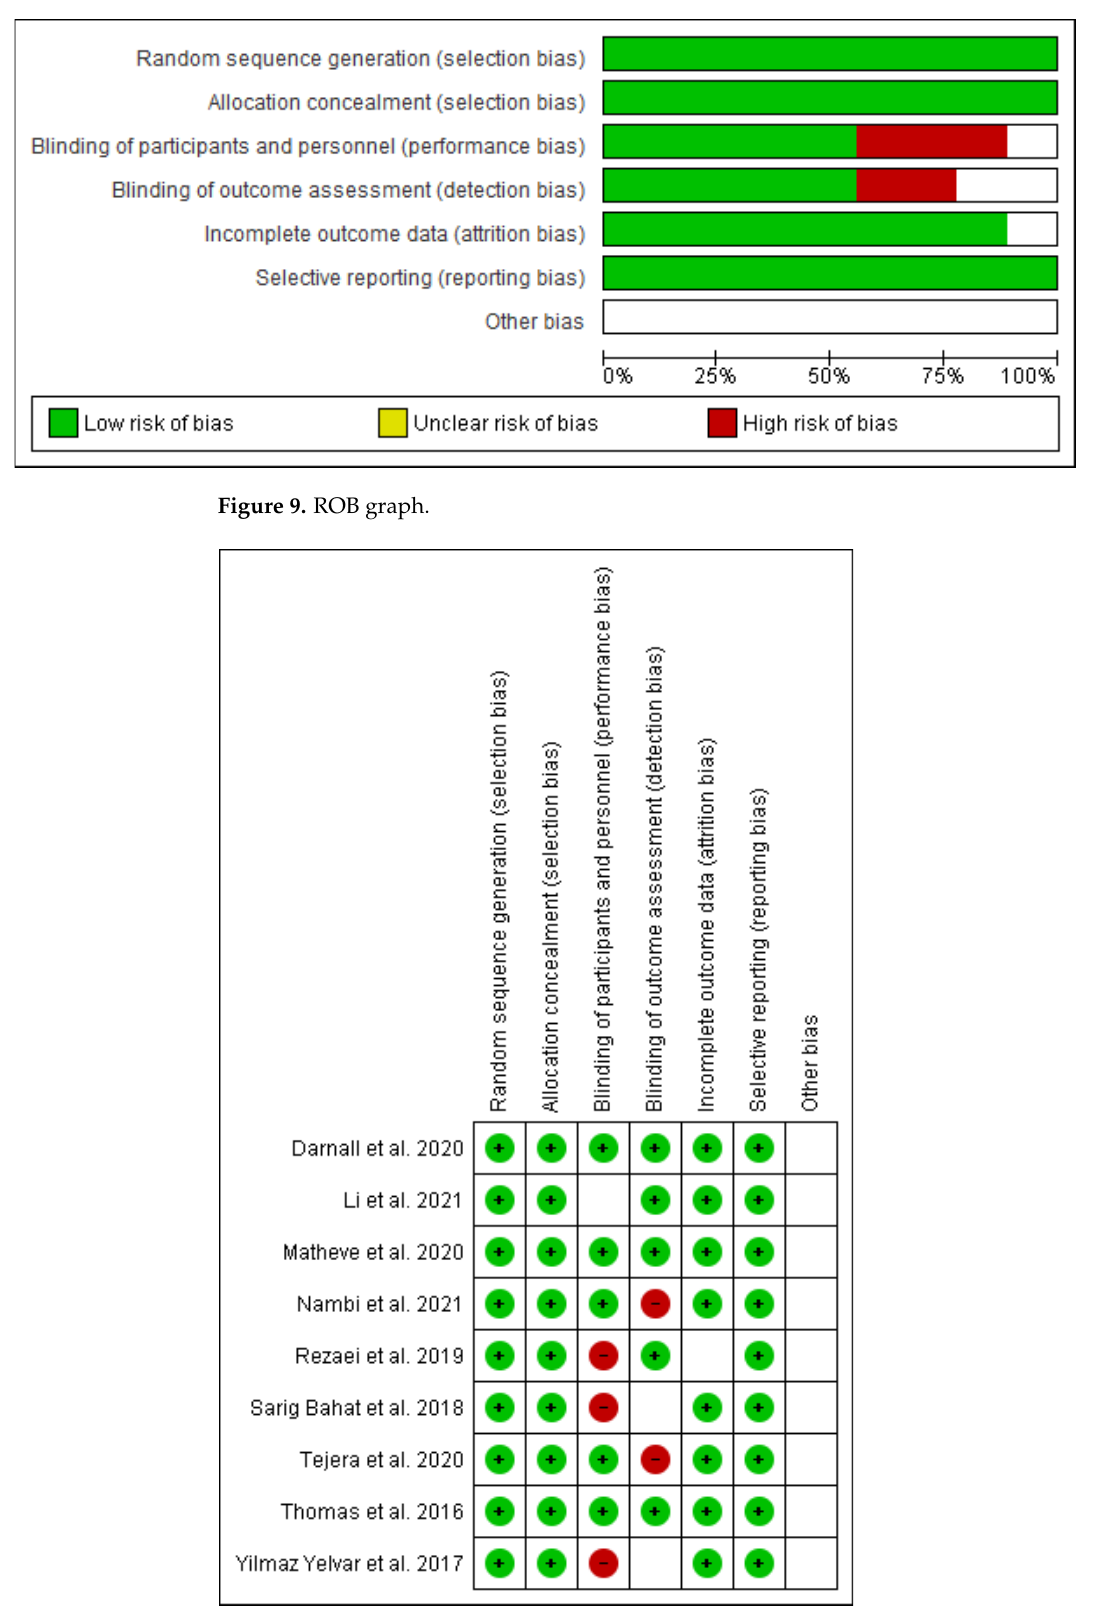
Figure 10. Summary of ROB for each included article.